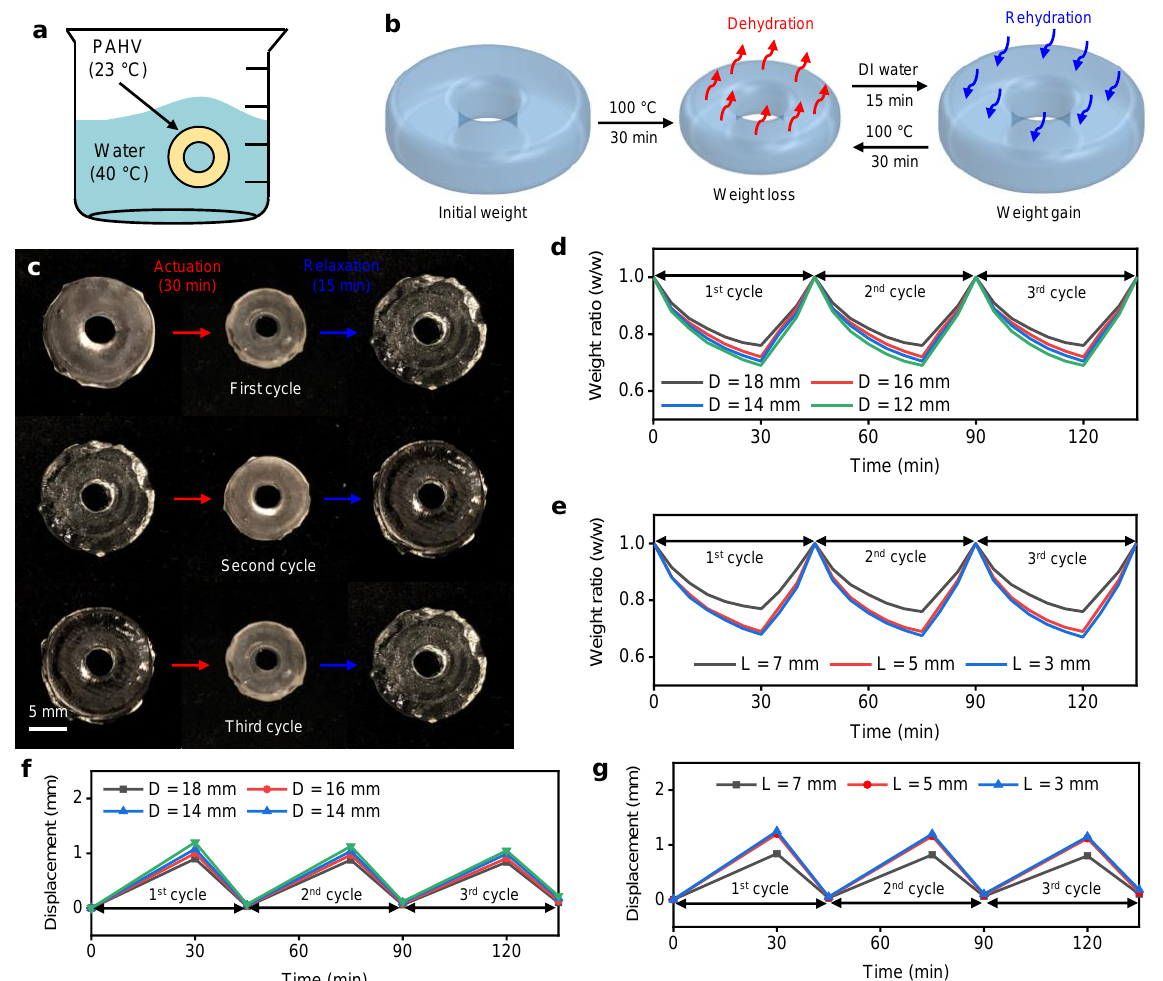
Figure 8. PAHV rehydration/controlled swelling kinetics. ( a ) Schematic showing the experimental set-up and ( b ) actuation and rehydration mechanisms. ( c ) Real-time images demonstrating actuation and rehydration of the PAHV’s actuation and rehydration cycles. ( d ) PAHV weight ratio changes for different diameters (12–18 mm) actuated at 100 ◦ C and rehydrated in DI water for 3 cycles. ( e ) PAHV weight ratio changes for different lengths (3–7 mm) actuated at 100 ◦ C and rehydrated in DI water for 3 cycles. ( f ) PAHV displacement at different diameters (12–18 mm) for 3 actuation–rehydration cycles. ( g ) PAHV displacement at different thicknesses (3–7 mm) for 3 actuation–rehydration